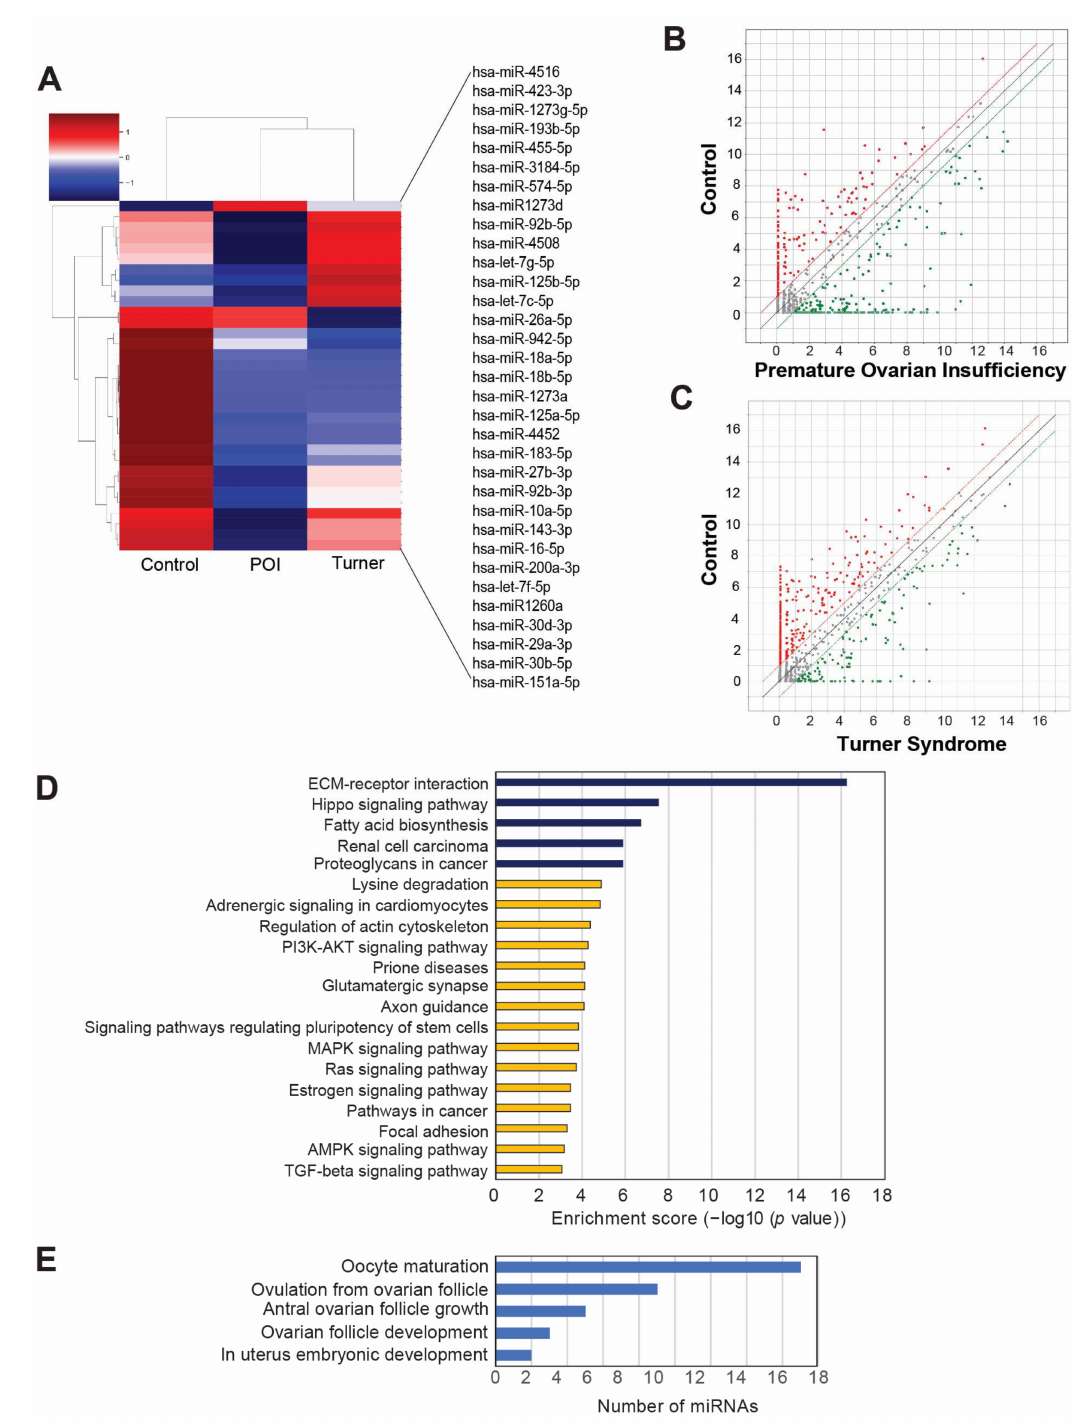
Figure 2. MicroRNA (miRNA) sequencing profile of urinary exosomes from patients with premature ovarian insufficiency (POI), Turner syndrome, and control individuals. ( A ) Heatmap with hierarchical clustering of 33 differentially expressed miRNAs ( p < 0.05). Red and green colors represent increased or reduced expressions across samples, respectively. ( B , C ) Scatterplots of miRNA profiles among patients with POI versus the control ( B ) and patients with Turner syndrome versus the control ( C ). ( D ) Top 20 statistically significant enriched pathways in the Kyoto Encyclopedia of Genes and Genomes (KEGG) analyses of the genes targeted by the 33 differentially expressed miRNAs. ( E ) Gene category analysis for the POI-related target genes of the 33 differentially expressed